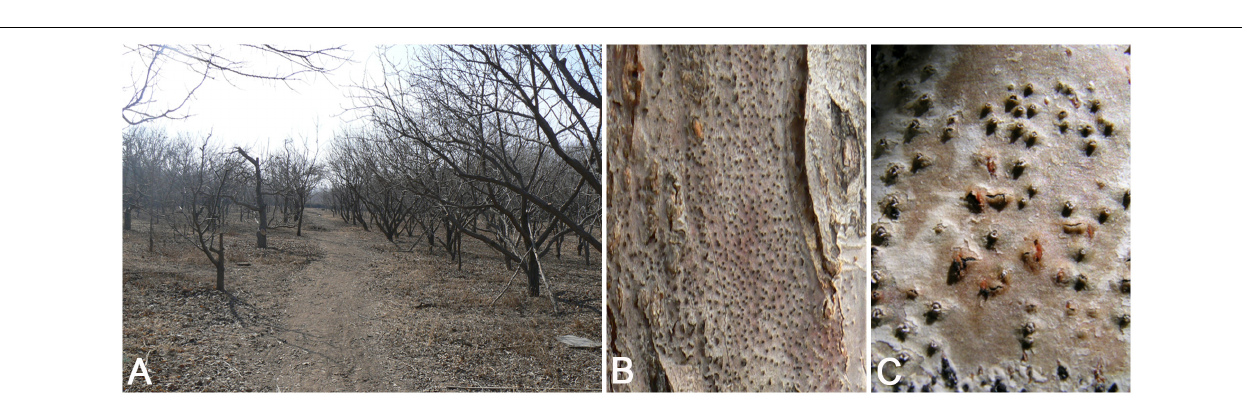
obtain consensus sequences using Seqman v.9.0.4